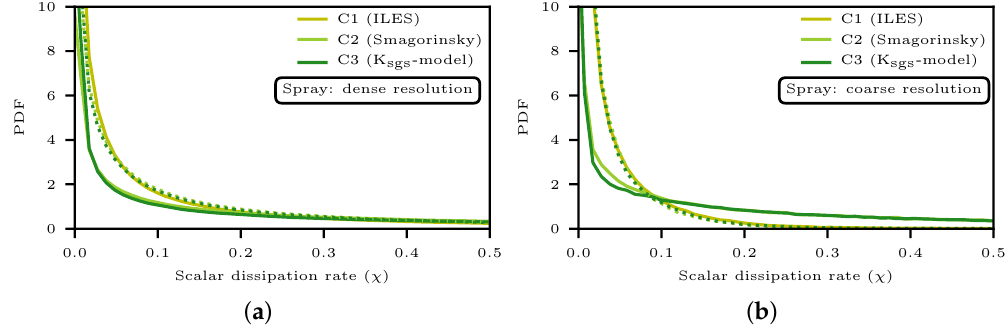
Figure 13. PDF of scalar dissipation rate ( χ ) at time t = 1.5 ms for ( a ) the dense mesh region of the spray, and ( b ) the coarse region of the spray. Dense and coarse resolutions of the spray are identified as the intersection between cell indices holding Z > 10 − 5 and those of cell volumes below or above a threshold of 1.1 × 62.5 3 µm 3 , respectively. Dotted lines represent the resolved χ computed using D eff = D , whereas continuous lines denote χ based on D eff = D + D sgs (In ILES, D sgs =